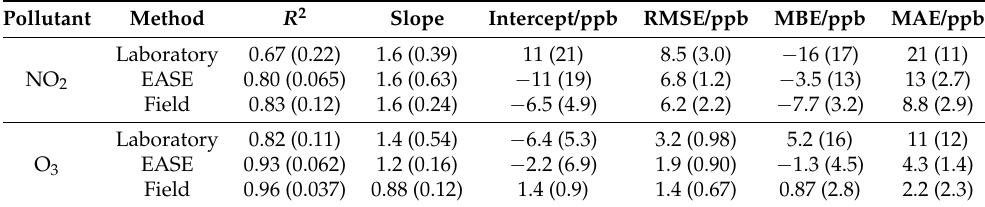
Table 3. Evaluation statistics for validation of the MOx nodes with all of the calibration methods, all values are means over all MOx nodes with their corresponding standard deviation of the results shown in